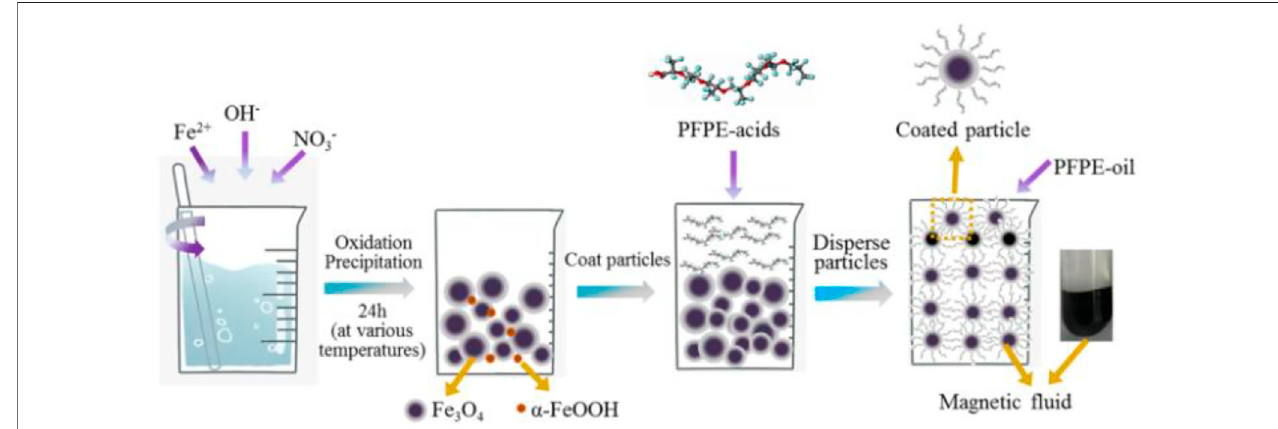
FIGURE 1 | Schematic illustration of the preparation process for Fe 3 O 4 nanoparticles dispersed in PFPE oil-based magnetic nano fl uids.